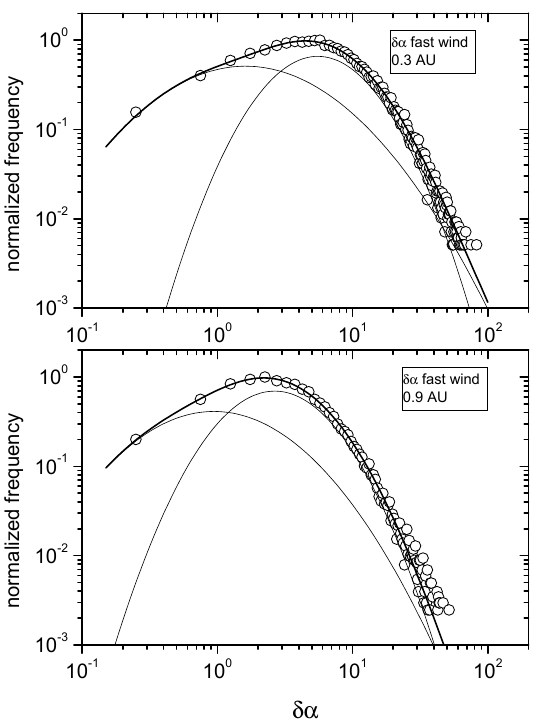
Figure 103: Probability distributions of the angular displacements experienced by magnetic vector on a time scale of 6 s at 0.3 and 0.9 AU, for a fast wind, respectively. Solid curves refer to lognormals contributing to form the thick solid curve which best fits the distribution. Image reproduced by permission from Bruno et al. (2004), copyright